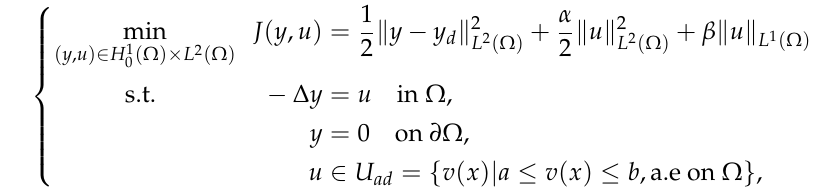
√ 2 for Example 1. ( b ) The numerical 2 7 √ 2 for Example 2 7